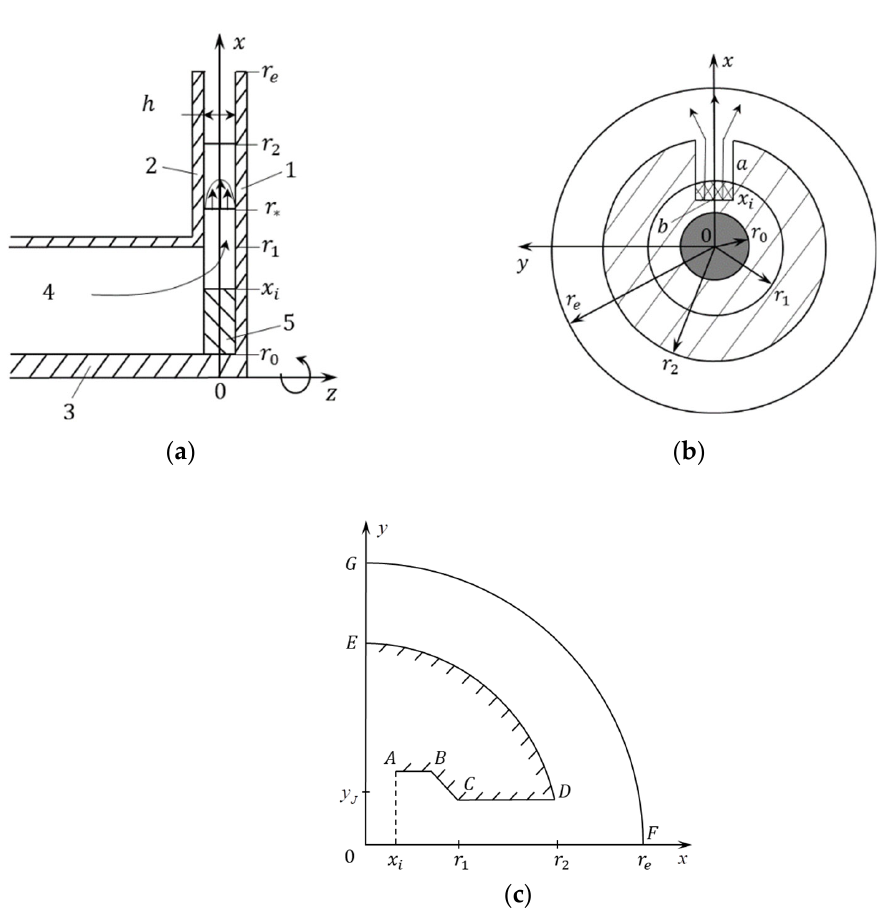
Figure 1. The flow region in the experiment: ( a ) in the ( x , z ) -plane; ( b ) in the ( x , y ) -plane; ( c ) com- putational domain in the ( , ) x y ‐ plane.